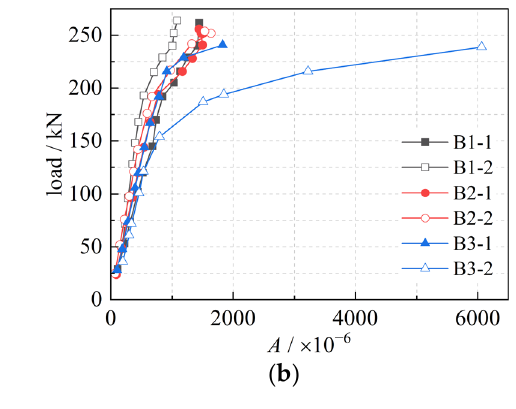
Figure 12. The variation in k and A ; ( a ) k ; ( b ) A .